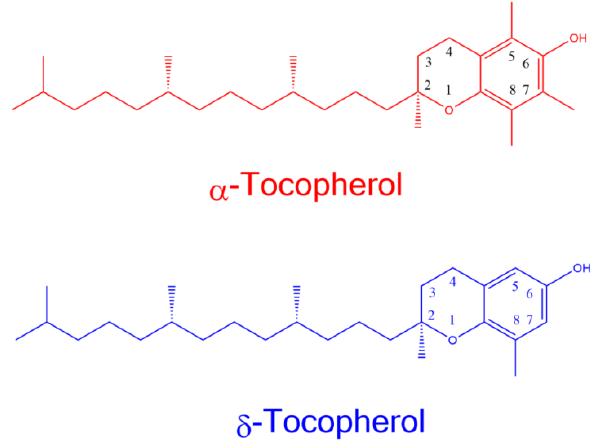
Scheme 2. Chemical structures of two of the four major forms of vitamin E ( α -, β -, γ -, and δ -tocoph- erols). In α -tocopherol (the most biologically active form), the chromanol ring is fully methylated, whereas δ -tocopherol is only methylated in position 8. Both tocopherols have a saturated phytyl side chain attached at C2 and have three chiral